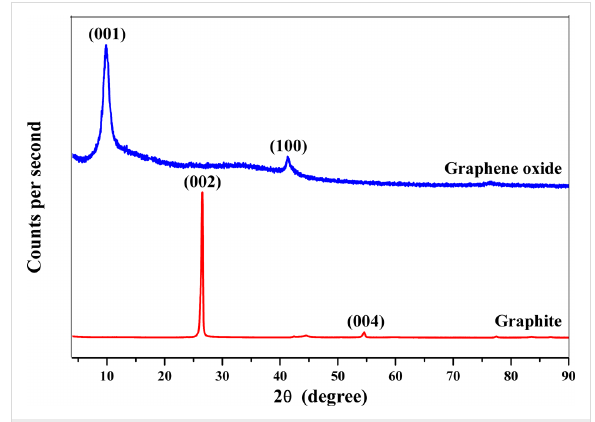
Figure 1: X-ray diffraction (XRD) spectra of pure graphite and synthe- sized graphene oxide. Deviation of XRD peak at 2 θ = 26.5° to 9.9° confirmed the successful oxidation of graphite